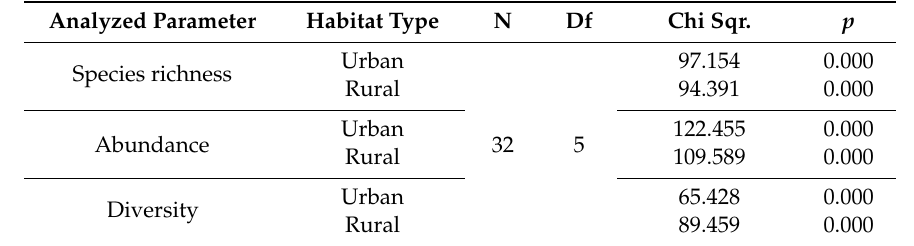
Table 4. E ff ect of month of the vegetative season on species richness, abundance, and diversity in urban and rural habitats, assessed by Friedman ANOVA (N is the number of the samples (trees) analyzed). Analyzed Parameter